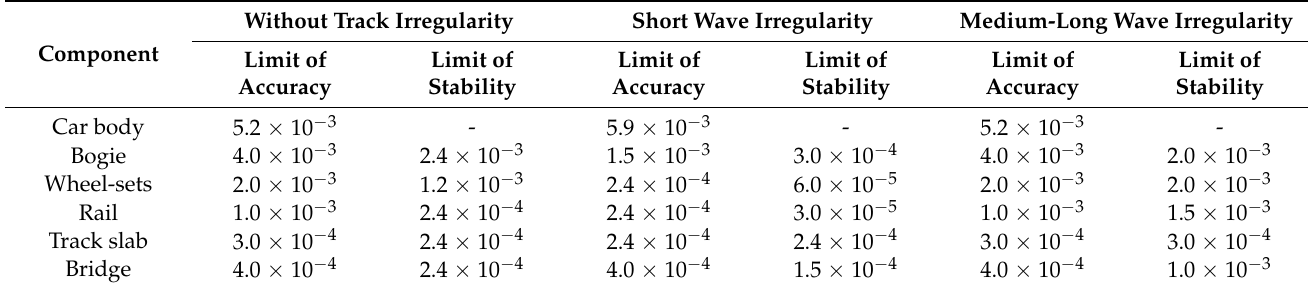
Table 7. Maximum of the Integration Time Step for Each Component under Different Track Irregularity States (unit: s). Without Track Component